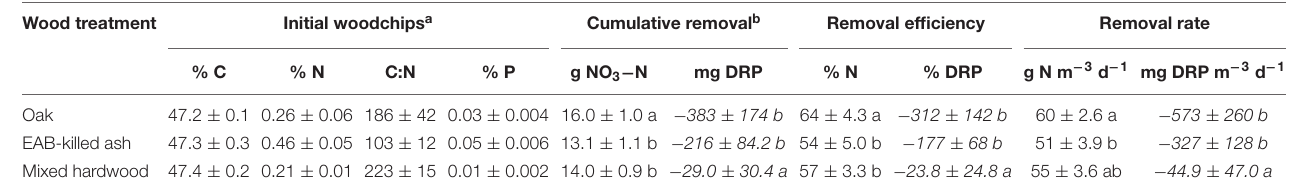
TABLE 1 | Initial woodchip nutrient content (C, carbon; N, nitrogen; P, phosphorus) and nitrate-nitrogen (NO 3 -N) and dissolved reactive phosphorus (DRP) removal for three wood types ( n = 6) in flow-through experiments. Wood treatment Initial woodchips a Cumulative removal